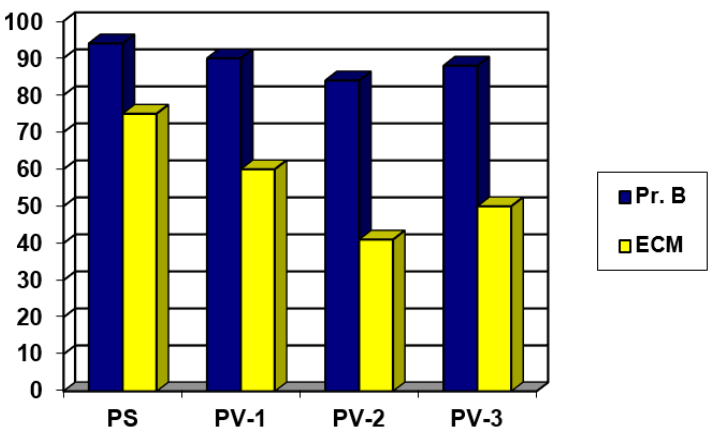
Figure 1. Percentage of target-like performance. Pr. B: simple transitive sentences; ECM: Exceptional